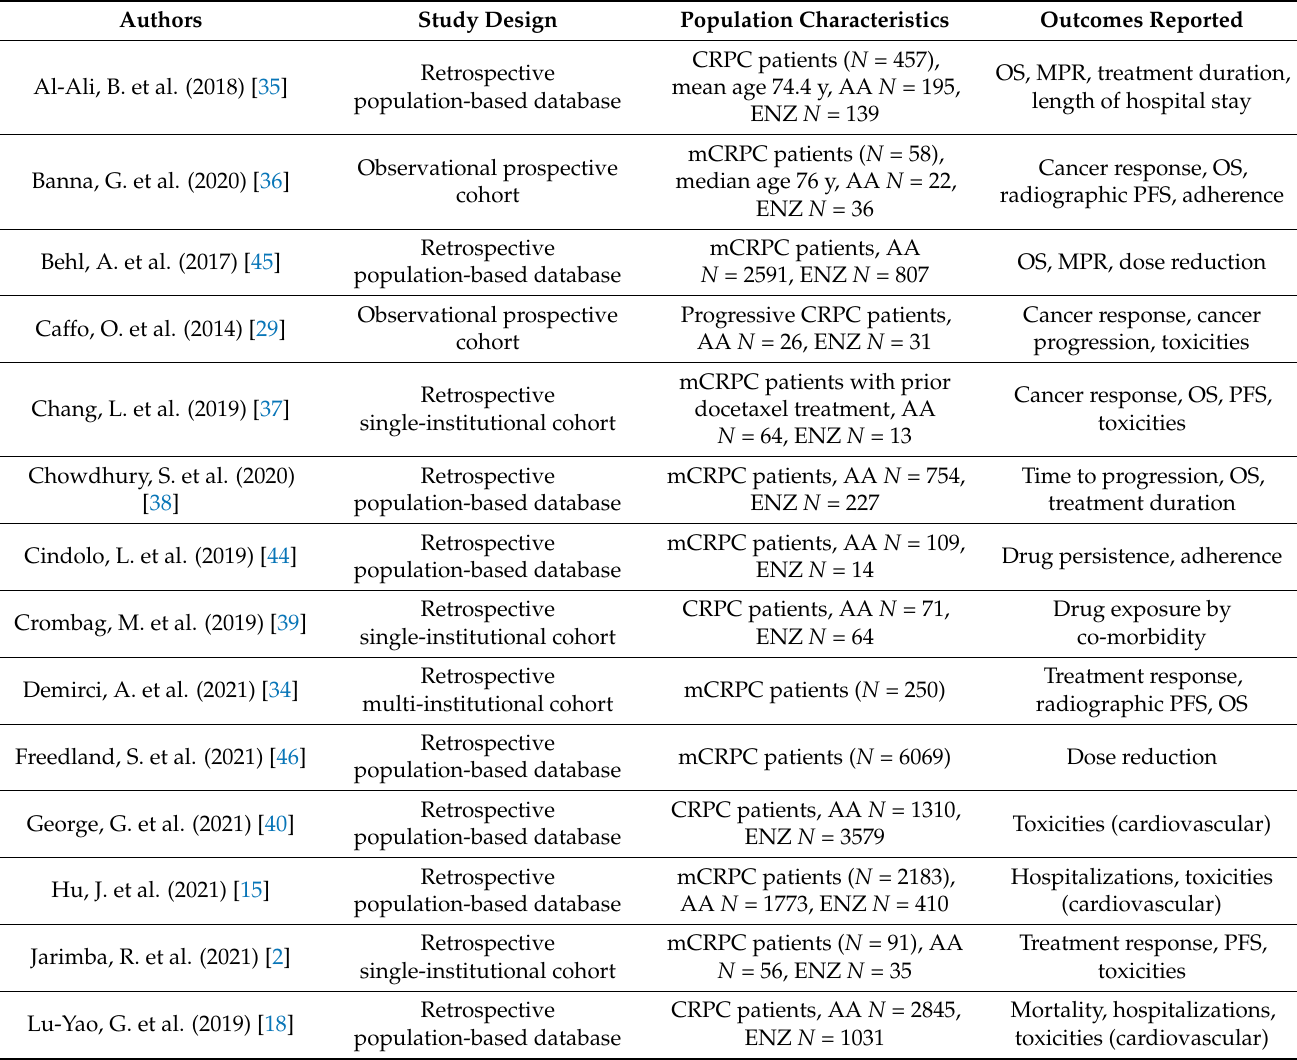
Table 2. Selected study